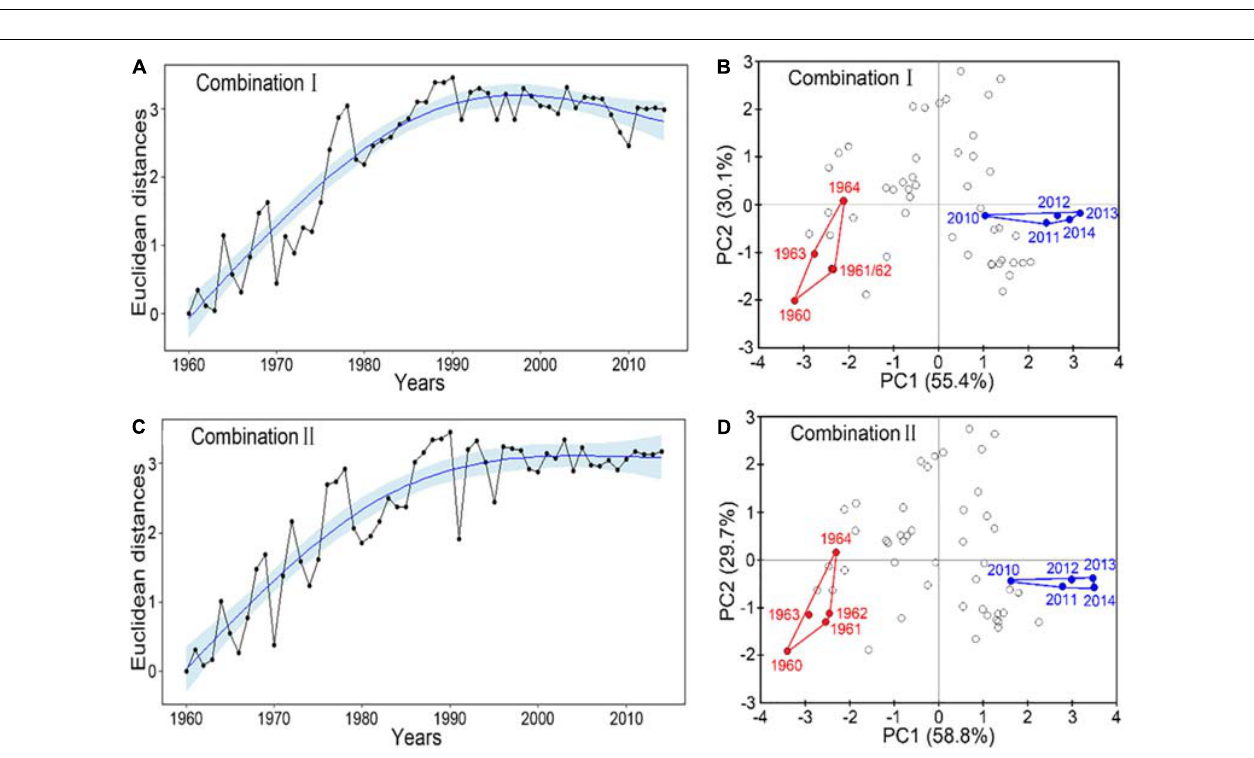
FIGURE 3 | Evaluation of the current fishery community structural state based on the final indicator suite. Panels (A,C) show the time trajectories of Euclidean distance in indicator state space from arbitrary reference year 1960, including a fitted trend with 95% confidence interval. The distance was calculated as the square root of the sum of squared distances between each standardized indicator value in a specific year and its reference value. Panels (B,D) show the location of the last 5 years in the time series (blue) in the 2-dimensional principal component (1st and 2nd) space in comparison to the state domain of the reference period 1960–1964 (red). Combination I consists of ToC, LPC/ToC, MTL, MTC, T-J (cid:48) FD; combination II consists of ToC, LPC/ToC, MTL, SPC, T-J (cid:48)